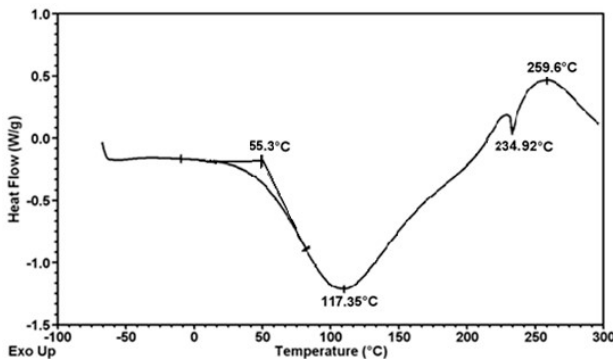
Figure 8. Thermogram of calcium alginate fiber without nano additive.